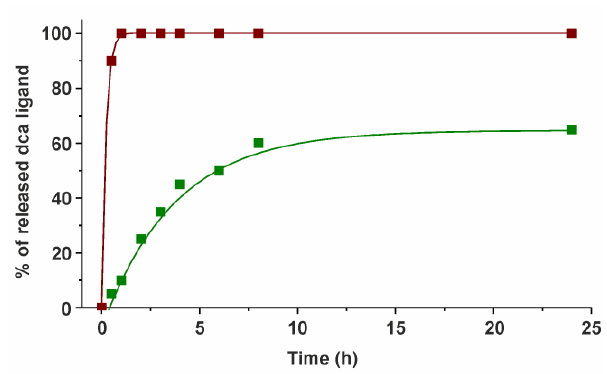
Figure 4. The results of the time-dependent 1 H NMR studies showing the progress of the dca ligand release for complexes Ru-dca (brown solid squares) and Os-dca (green solid squares). Note: The lines are only guides for eyes.